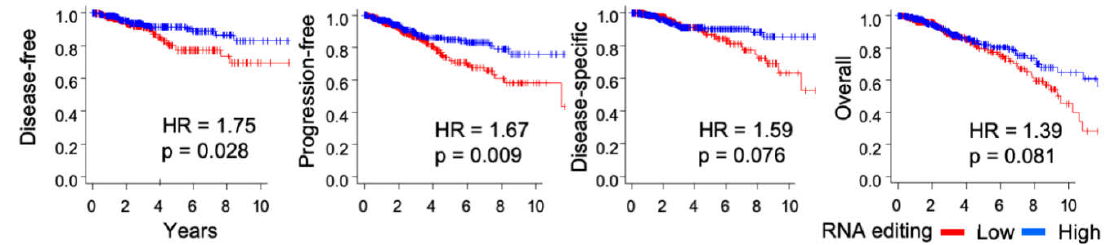
Figure 6. RNA editing is associated with improved survival. Kaplan–Meier survival plots along with log-rank test p -value and Cox proportional hazard ratio (HR) value are shown for association of RNA editing in tumors with disease-free, progression-free, disease-specific, and overall survival of patients. Groups of RNA editing-high and -low cases are compared.